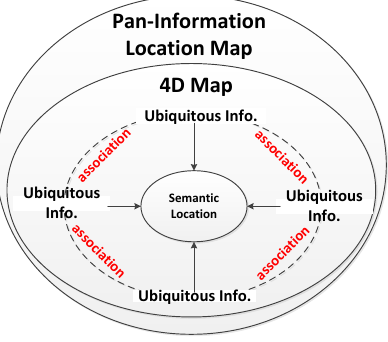
Figure 1. The representation of Pan-information Location Map